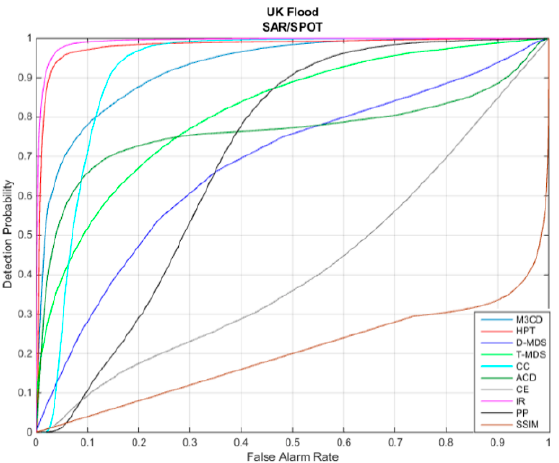
Figure 3. ROC curves for Image Pair-1 (SAR / SPOT) without EMAP. ROC: Receiver operating characteristics; EMAP: Extended Multi-Attribute Profiles.